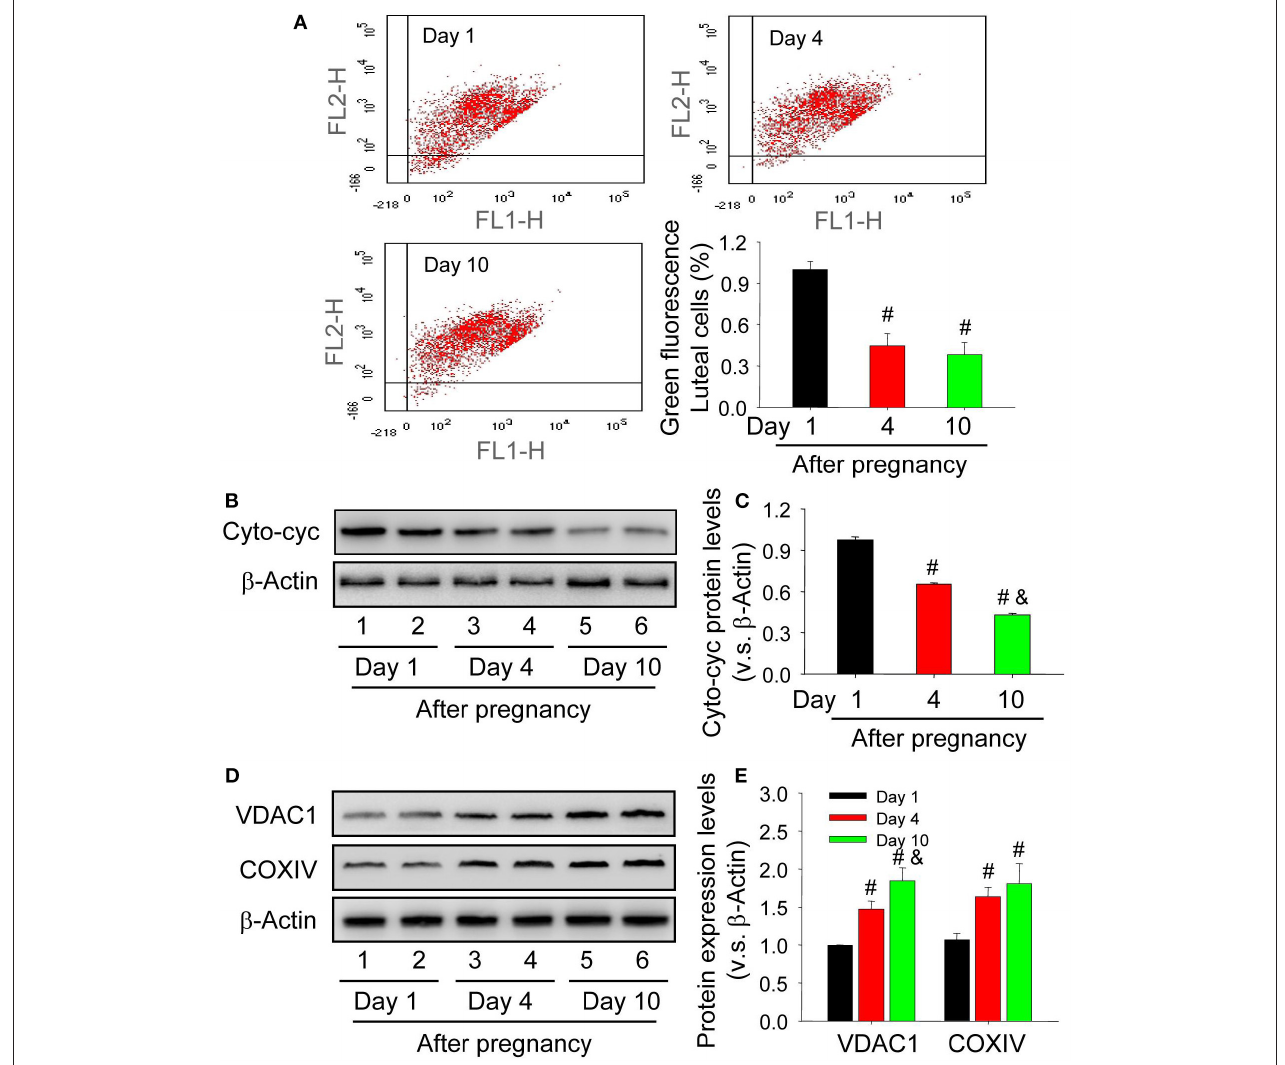
FIGURE 6 | Unsteadiness of mitochondria contributes to the release of cytochrome c in the cytoplasm of luteal cells. (A) Mitochondrial membrane potential was evaluated by JC-1 staining and analyzed by flow cytometry. The integral segment is labeled as JC-1 red (upper right fraction) and the mitochondria with low potential is labeled as JC-1 green (damaged fraction). (B) Expression changes of cytoplasmic cytochrome c in luteal cells during the development of corpus luteum (from Day 1 to 10). (C) Summarized intensities of cytoplasmic cytochrome c bloting normalized to the control (Day 1). (D) Expression changes of VDAC1 and COXIV in luteal cells during the development of corpus luteum. (E) Summarized intensities of VDAC1 and COXIV bloting normalized to the control (Day 1). Each value represents the mean ± SE. One-way analysis of variance (ANOVA) was used to analyze the data, followed by a Tukey’s multiple range test. n = 6. Cyto-cyc, cytoplasmic cytochrome c, # P < 0.05, vs. the group in black; & P < 0.05, vs. the group in